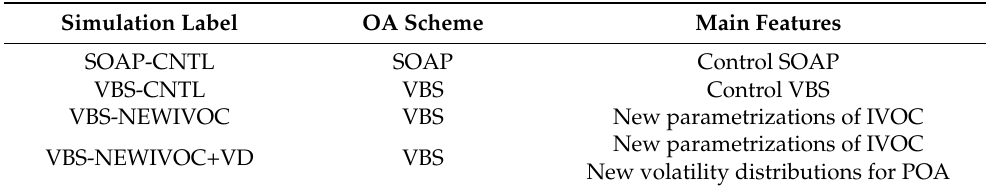
Table 1. Labels and main features of the simulations presented in this work.